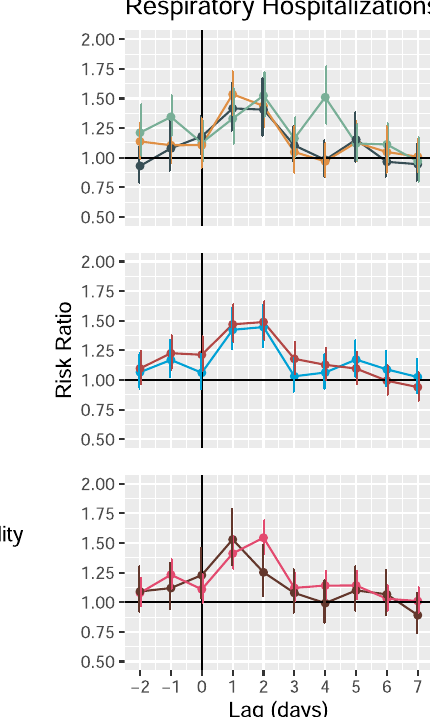
Fig. 3 | Association between tropical cyclone exposure and CVD and RD hospitalization risk in Florida ZCTAs ( n =796) from 1999 to 2016, from 2 days beforeto7 daysafter a storm day, strati fi ed byindividual-levelcharacteristics